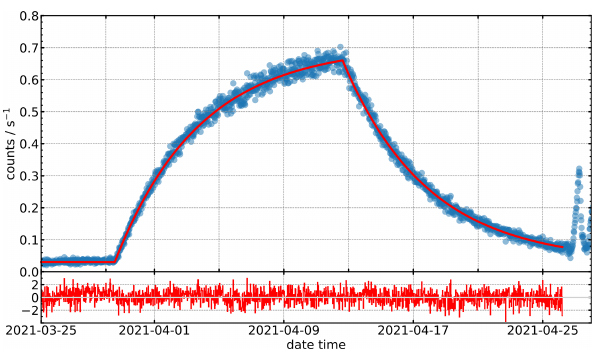
Figure 8. Comparison of measured and calculated count rate in the PTB climate chamber based on a well characterized radon emanation source. Emanation source no. 2018–1121: A (Ra- 226) = (1136 ± 5)Bq produces an equilibrium activity concentration of (18 . 09 ± 0 . 17)Bqm − 3 in the climate chamber of PTB.